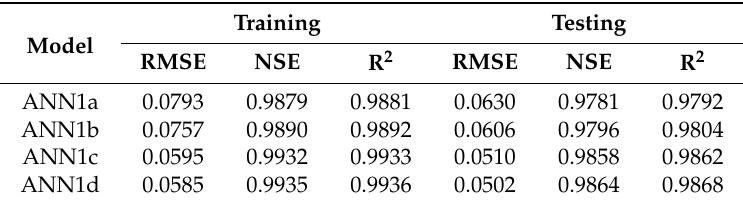
Table 4. Statistical measurement of 1 h forecasts for the entire data set.